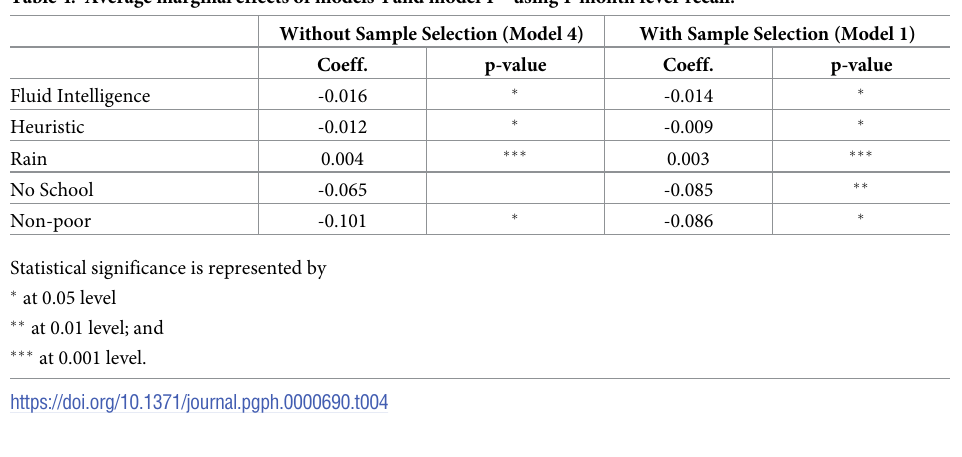
Table 4. Average marginal effects of models 4 and model 1—using 1-month fever